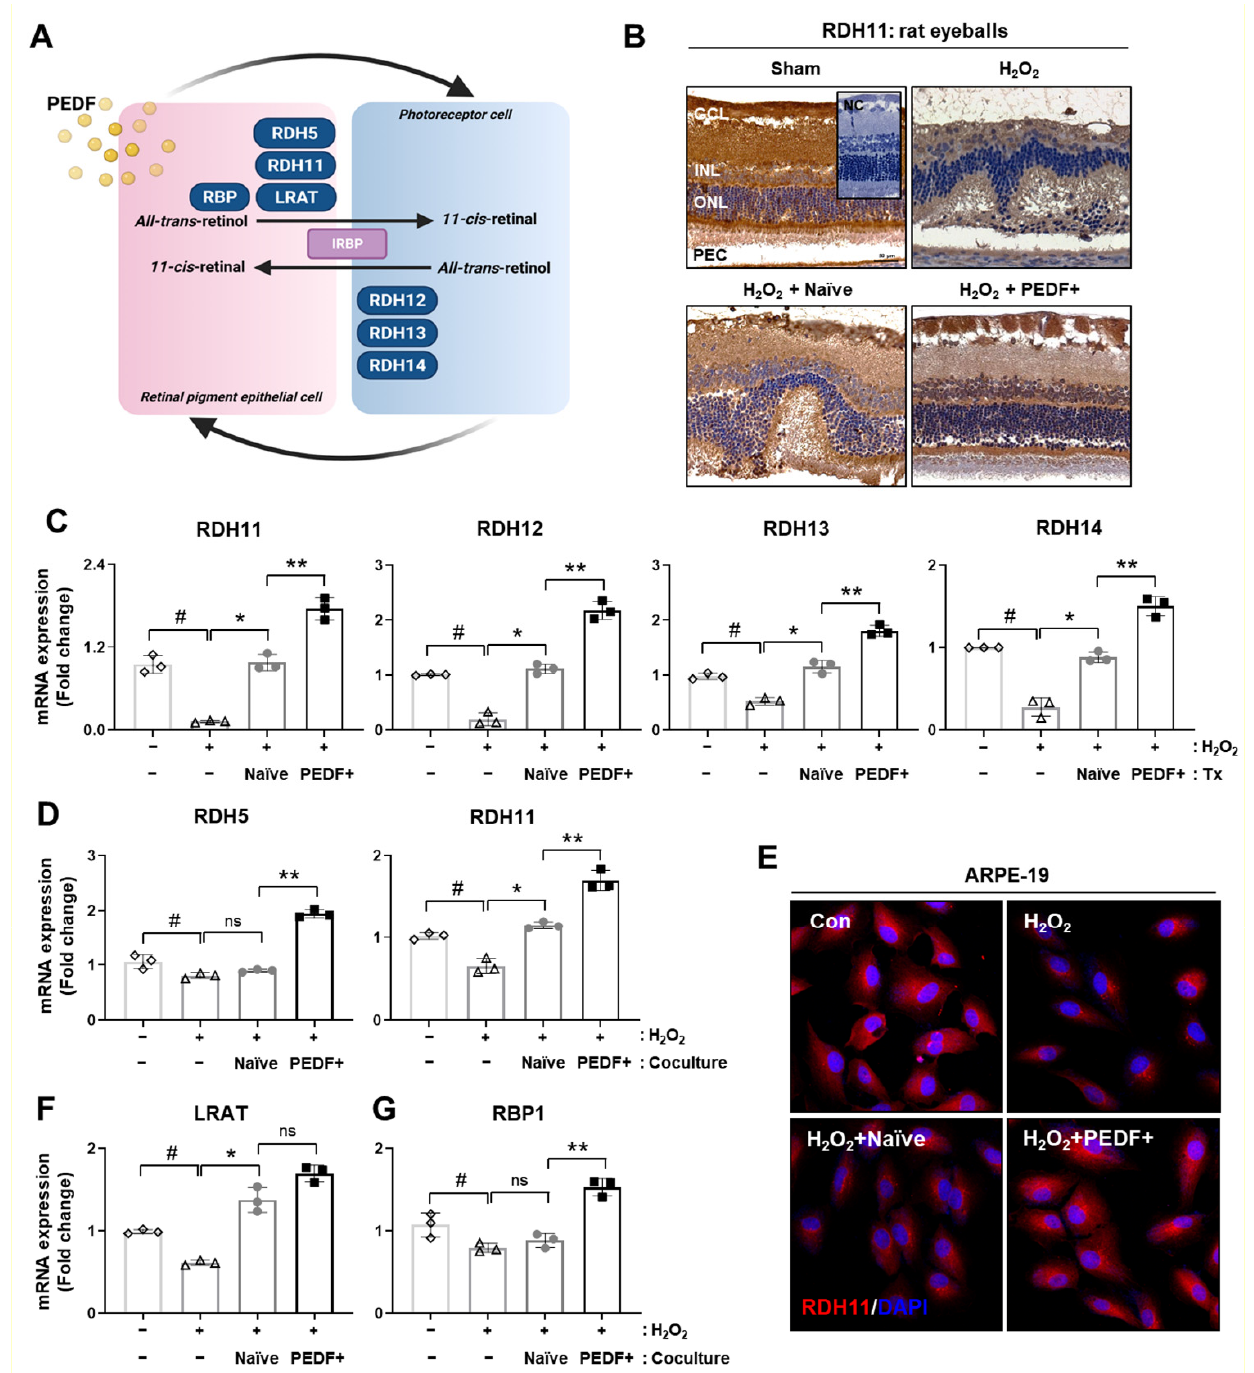
Figure 4. PD-MSCs PEDF improved the visual cycles of rat retinal layers and RPE cells. ( A ) Summarized diagram of visual cycles in photoreceptor cells and RPE cells. ( B ) IHC staining showing RDH11 expression in H 2 O 2 -injured rat retinas after naïve PD-MSC (H 2 O 2 + Naïve) and PD-MSC PEDF (H 2 O 2 + PEDF+) transplantation. ( C ) The mRNA expression of visual cycle genes in photoreceptors (e.g., RDH 12, 13, and 14) and RPE cells (e.g., RDH11) of each group ( n = 6). # p < 0.05 vs. Sham ( − ), * p < 0.05 vs. H 2 O 2 , ** p < 0.05 vs. H 2 O 2 + Naïve. ( D ) mRNA expression of the visual cycle of RPE genes (e.g., RDH5, RDH11, LRAT, and RBP1) in ARPE-19 cells. ( E ) Representative images showing RDH11 (red) in ARPE-19 cells by IF staining. DAPI (blue) was used for counterstaining. Scale bar = 100 µ m. The mRNA expression of ( F ) LRAT and ( G ) RBP1 in ARPE-19. The data represent the mean ± SD and were analyzed by one-way ANOVA. # p < 0.05 vs. normal control ( − ), * p < 0.05 vs. H 2 O 2 , ** p < 0.05 vs. Naïve.